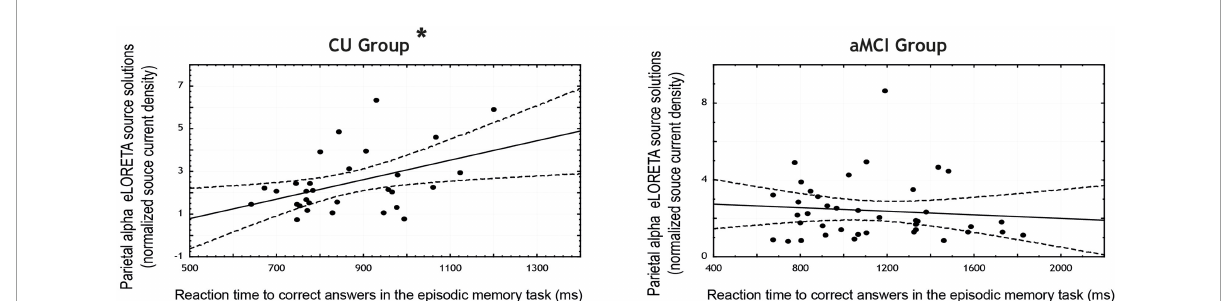
FIGURE2 Scatterplots for the CU and aMCI groups showing the correlation between eLORETA source solutions (normalized alpha current source density) of parietal alpha resting state EEG (rsEEG) rhythms and the reaction time to correct answers in the episodic memory task (in ms). Note that * indicates significant correlations ( p < 0.05 and r > 0.3).